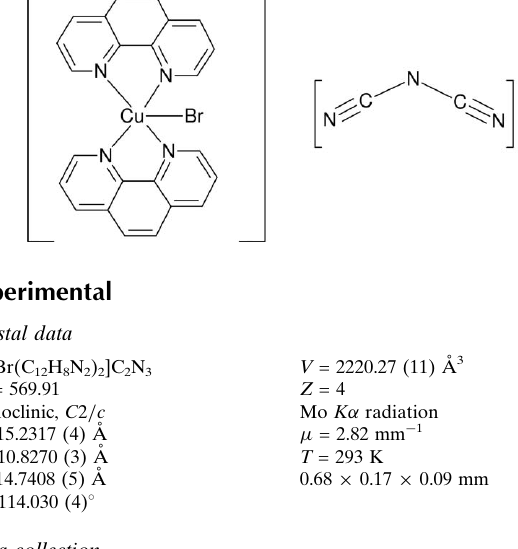
Data collection Oxford Diffraction Xcalibur2 CCD diffractometer